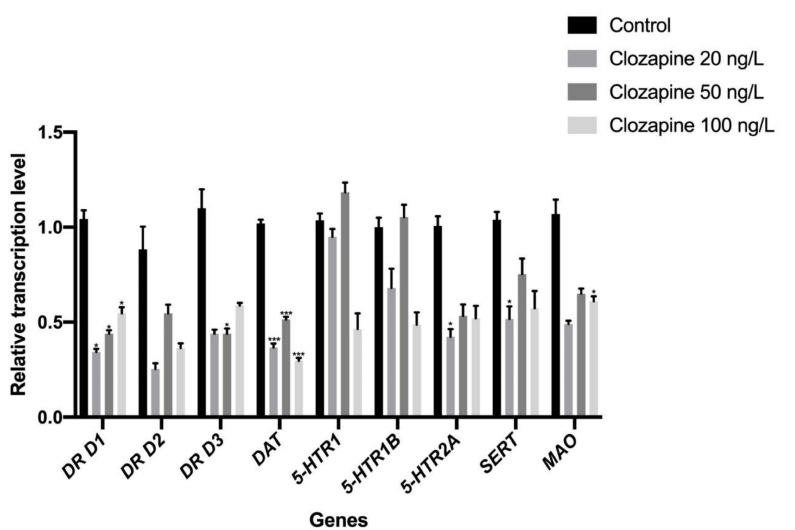
Figure 2. Clozapine exposure for 14 days induced changes in gene transcription levels of functional molecules of DA and 5-HT neurotransmitter system in octopus brain tissue. Note: * compared with the control group, p < 0.05; *** compared with the control group, p < 0.001; n = 5.